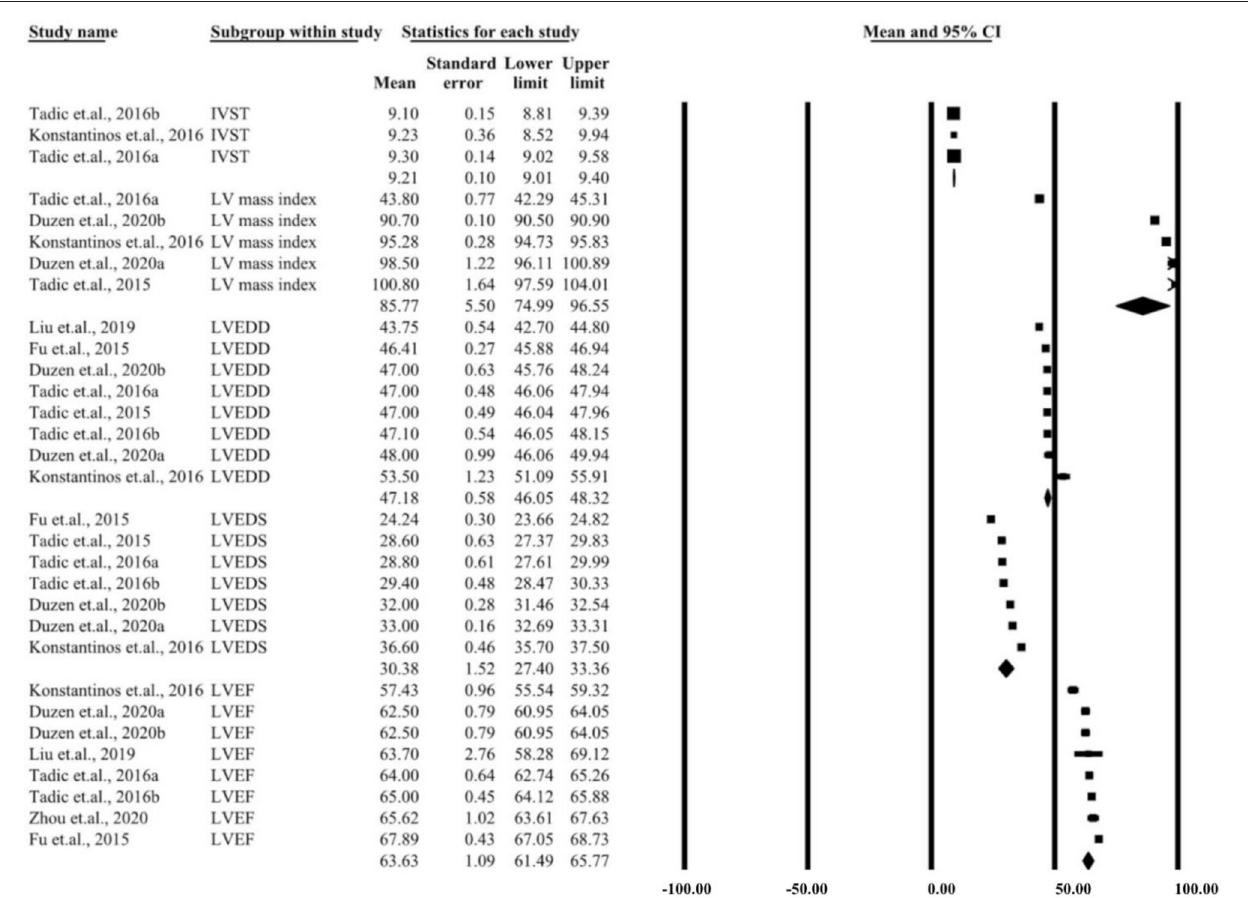
FIGURE 3 | Summary of two-dimensional echocardiographic parameters for left ventricular case group.